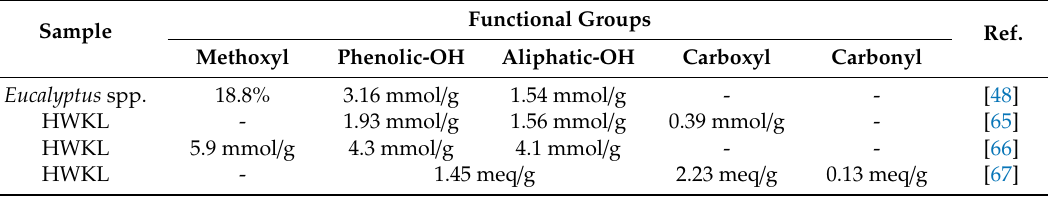
Table 4. Functional groups in hardwood kraft lignins.